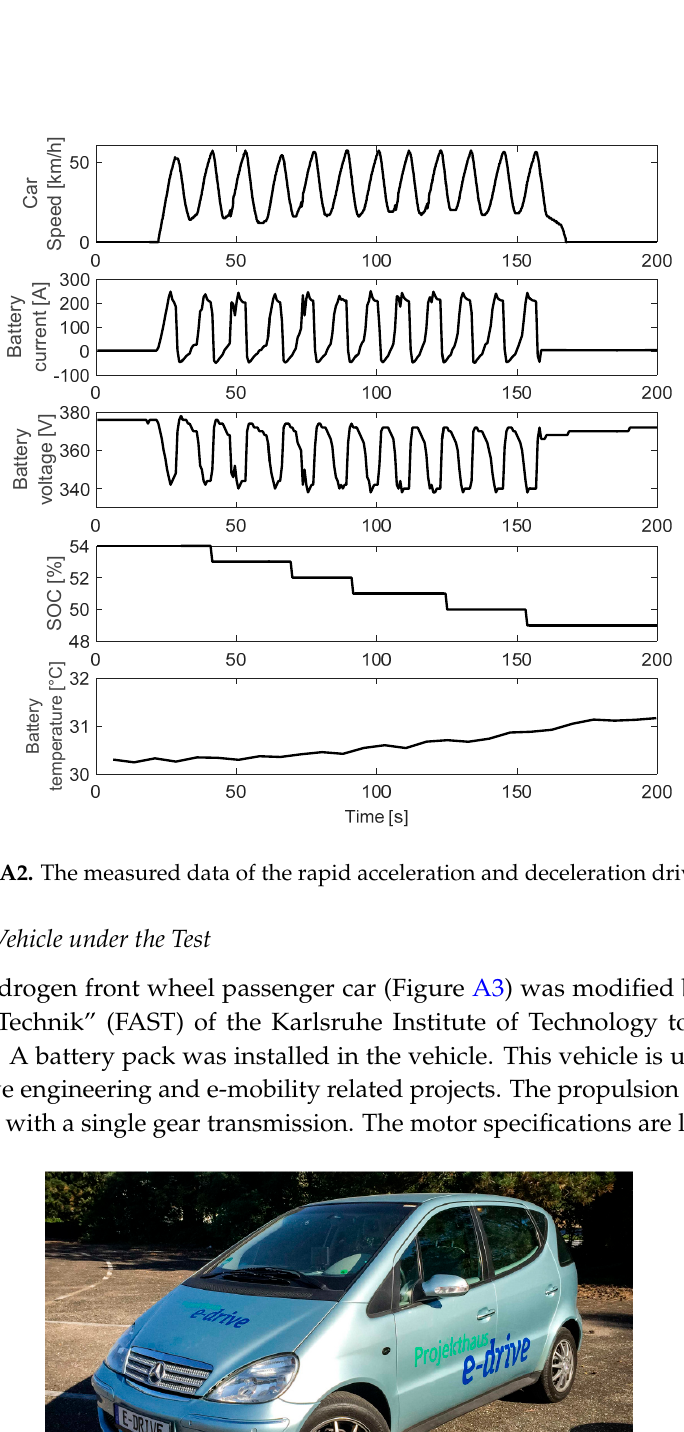
Figure C1. Vehicle under test.